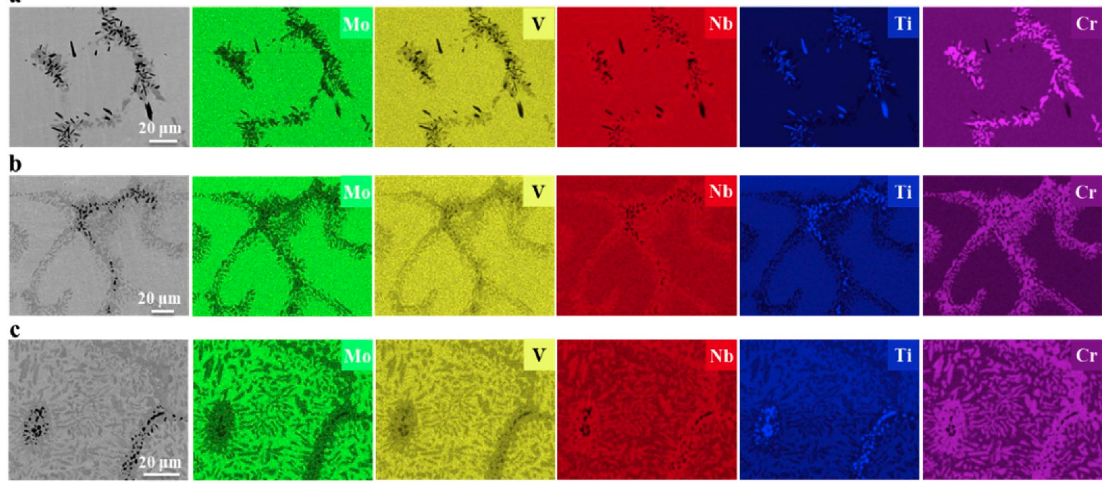
Figure 4. SEM/EDS mappings of Mo, V, Nb, Ti and Cr in the annealed ( a ) Cr1.0, ( b ) Cr1.5 and ( c ) Cr2.0 alloys. Reprinted with permission from Ref. [26]. Copyright 2020 Elsevier.